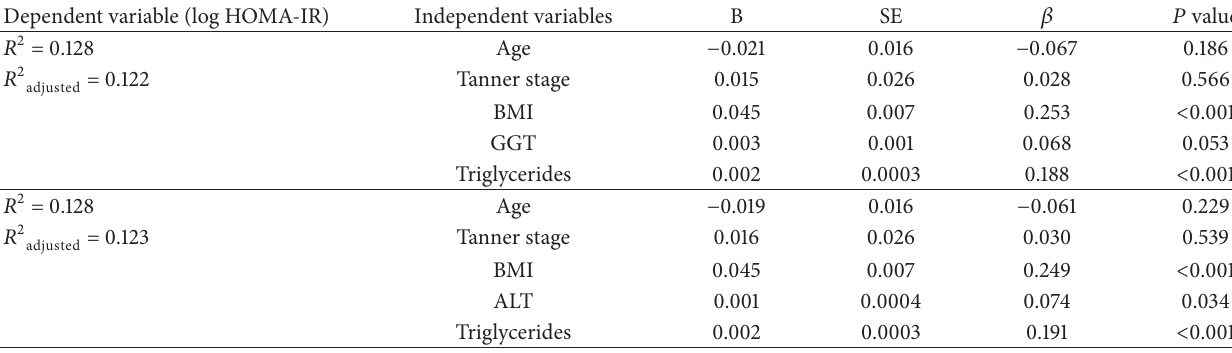
Table 4: Multiple linear regression analysis in boys.